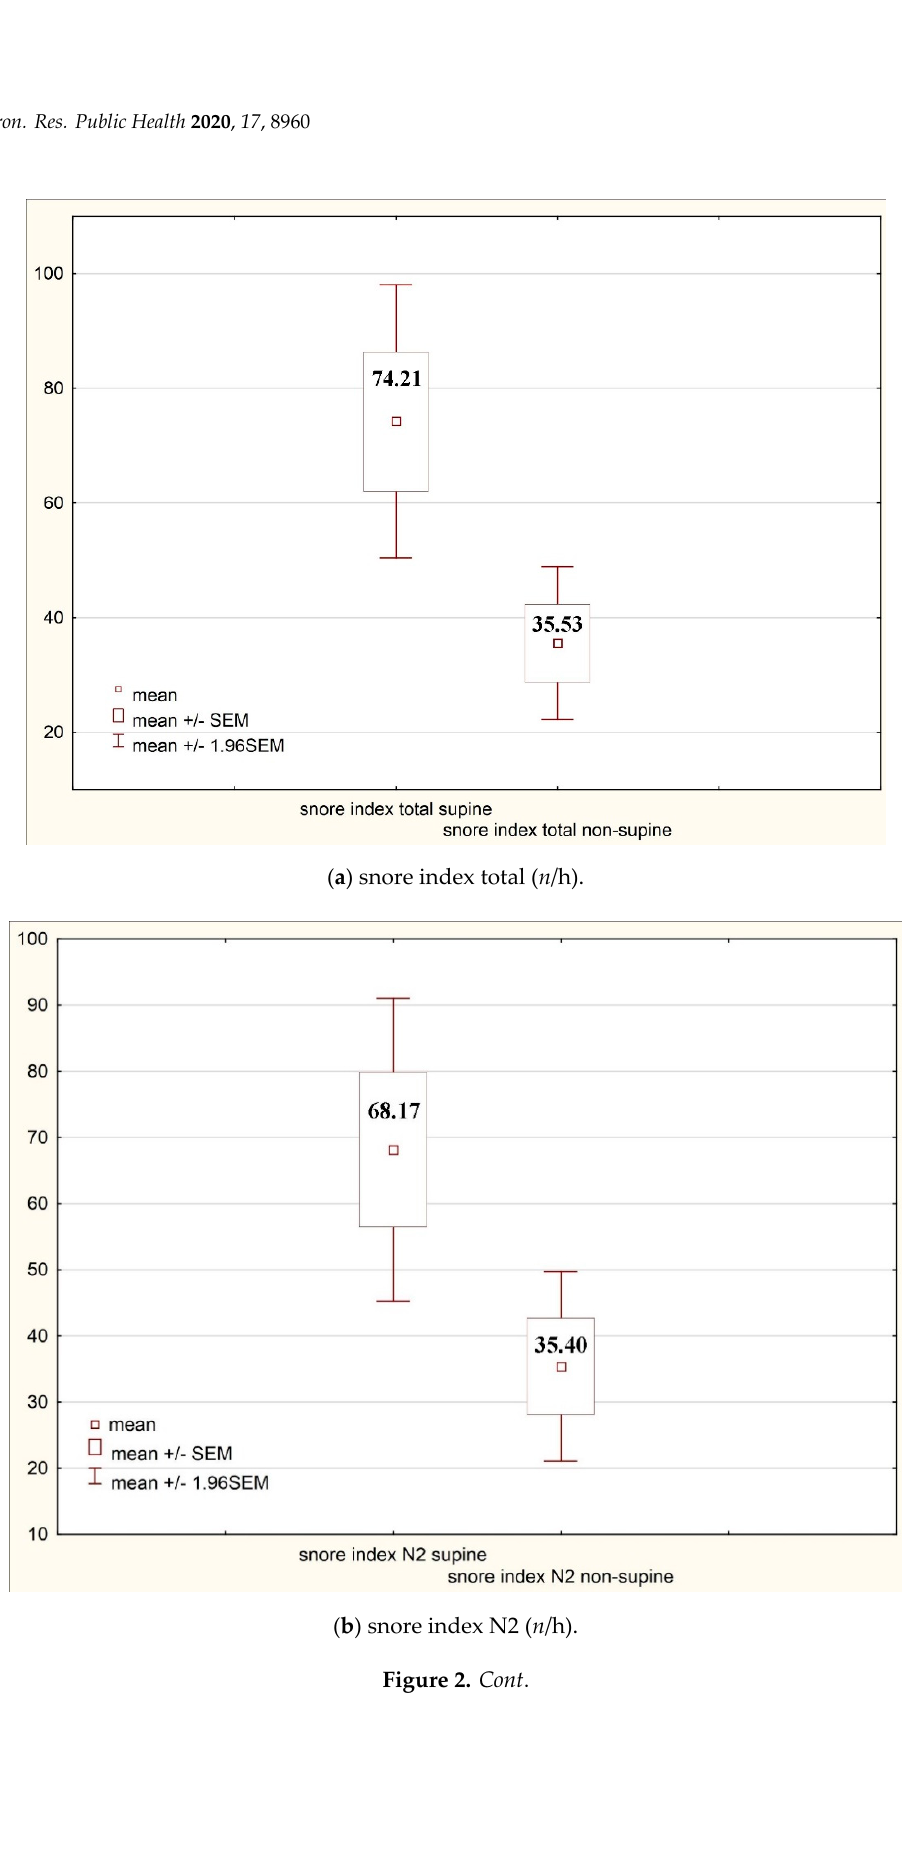
Figure 1. Impact of the body position on bruxism indices.